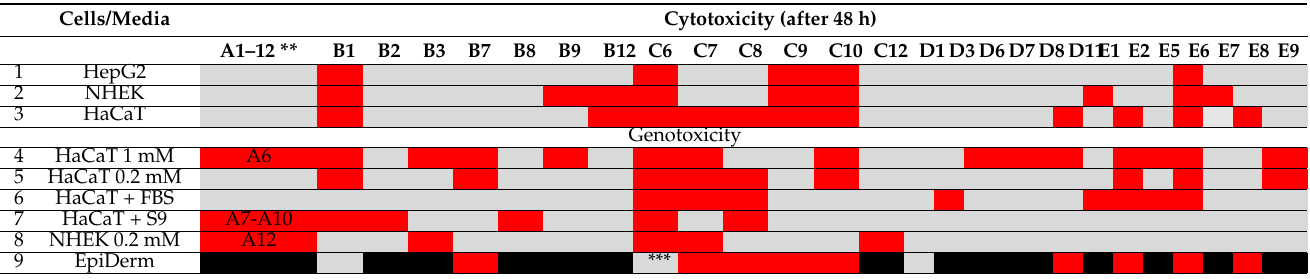
* Red boxes: cyto- or genotoxic. Gray boxes: negative for cyto- or genotoxicity. Black boxes: not tested. ** A1–12 shown in just one column, since most are non-toxic. *** Compound C6 was applied topically in acetone, but it is insoluble, and thus it did not show DNA